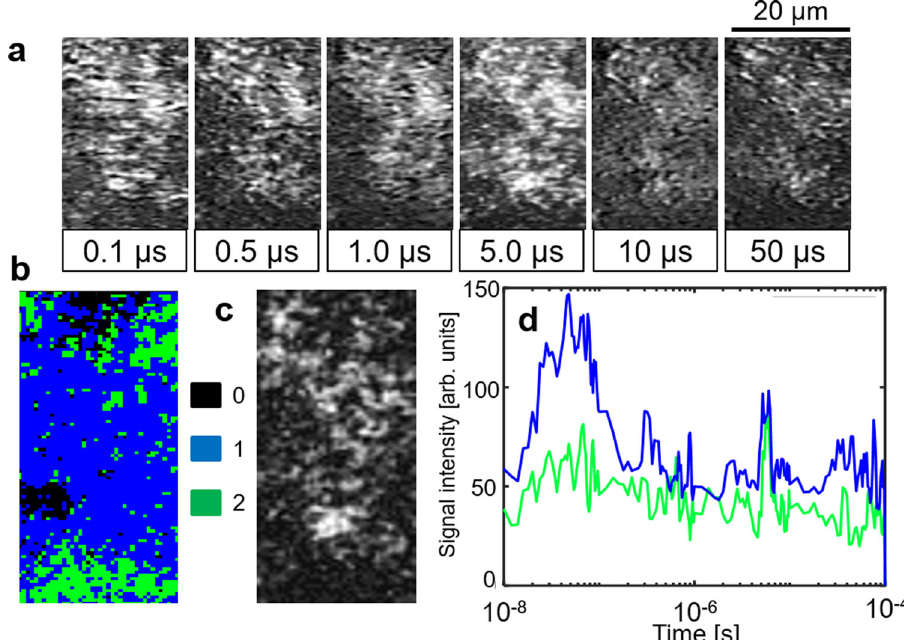
Fig. 6 Image sequence and clustering analysis in water. a An image sequence of the refractive index response for SrTiO 3 :Rh/ITOBiVO 4 :Mo (STOR/ITO/ BVOM) in water in a square region (20 × 50 μ m) corresponding to no. 1 on the order of nanoseconds to microseconds. The location of the sample was exactly the same as Fig. 5a. The scale bar corresponds to 20 µ m. b The categorized mapping of the charge carrier responses of a . An outlier positioned far from all categories was colored in black (#0) c A microscopic image in the same area as a . d The averaged responses for each category in b are shown. (blue: category 1, green: category